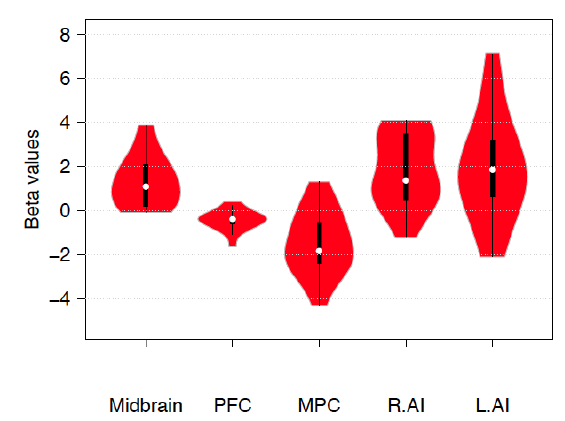
Figure 1. Violin plots representing estimated beta values for the contrast up > down emotion regulation in the midbrain (5, − 26, − 10), prefrontal cortex (PFC, − 21, 30, − 10), medial parietal cortex (MPC, 2, − 30, 50), and left and right AI ( − 37, 20, 0 and 42, 13, 5). White circles show the medians; box limits indicate the 25th and 75th percentiles as determined by the R software; whiskers extend 1.5 times the interquartile range from the 25th and 75th percentiles; polygons represent density estimates of beta values and extend to extreme values. Violin plots were created with BoxPLotR (http: // shiny.chemgrid.org / boxplotr / ) [65].